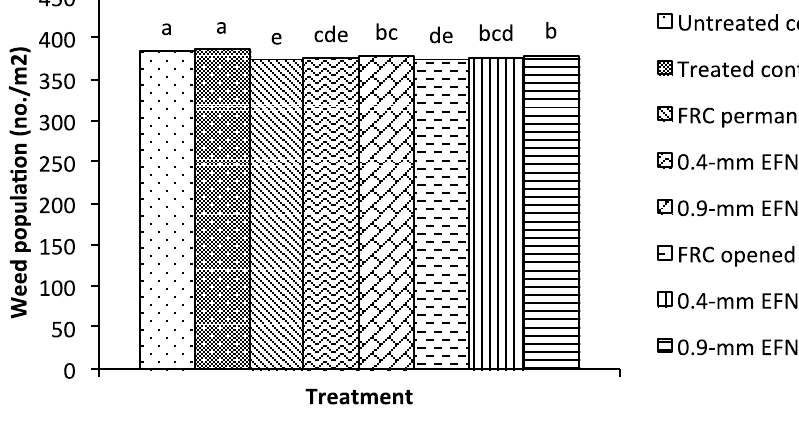
Figure 2. Effects of floating row covers (FRC) and eco-friendly nets (EFN) on mean weed population during tomato production. Values shown are averages for two growing seasons (May to October 2011 and October 2011 to March 2012). Bars having the same letter are not significantly different according to Tukey’s honest significant difference (THSD) at p ≤ 0.05. Untreated control had no pesticide applied, treated control was sprayed with pesticides, permanent is where the FRC or EFN were covered throughout except during crop maintenance periods, and opened is where the FRC or EFN were opened thrice a week from 9:00 am to 3:00